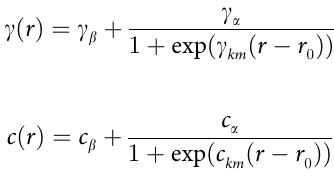
Fig 3. A simple reaction-diffusion model for gradients of activity. A) Schematic of the simple reaction-diffusion model in which a species , which depends on the local IgG concentration, and is deactivated at a constant rate δ X is activated by a rate k x (r) model for various diffusion rates D x . The spatial profile of k x (r) is shown as the dashed line and δ x = 0.75 s -1 . The homogenous steady states and k = k are shown as well (dotted lines). C) Maximum slope of X(r) and percent increase of X(0) over X values of X when k = k x (0) x (r max ) (r max ) as a function of D . D) Blue curves are same as in B and dashed lines are best fits of these curves to the logistic function (see Methods x for curve fitting details).